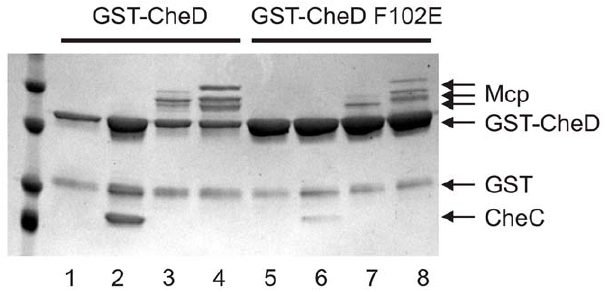
Figure 4. GST pulldowns with CheD’s two binding partners (CheC and McpAc) show reduced binding by GST-CheD-F102E. Lanes 1 (GST-CheD only control), 2 ( + CheC), 3 ( + McpAc) and 4 ( + McpCc) contain GST-CheD bound to glutathione beads. Lanes 5 (GST-CheD- F102E only control), 6 ( + CheC), 7 ( + McpAc) and 8 ( + McpCc) contains GST-CheD-F102E bound to glutathione beads. Multiple bands of the